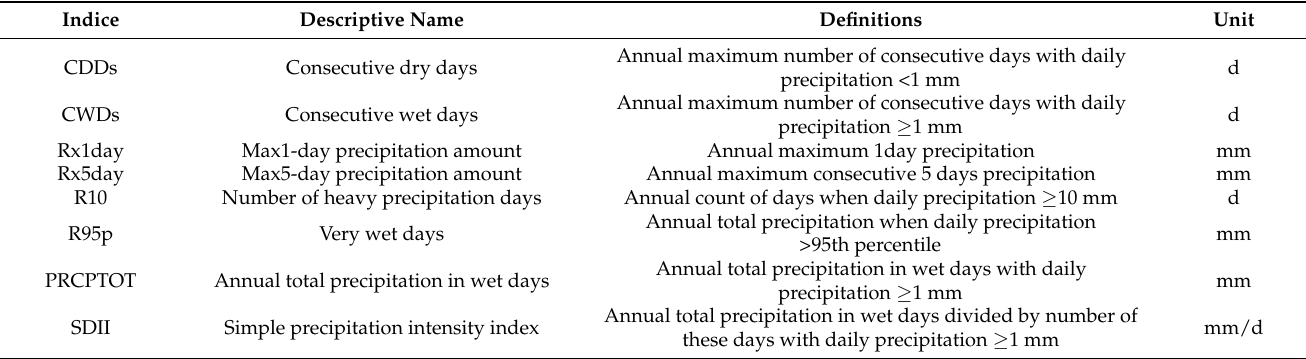
Table 1. Definitions of eight precipitation